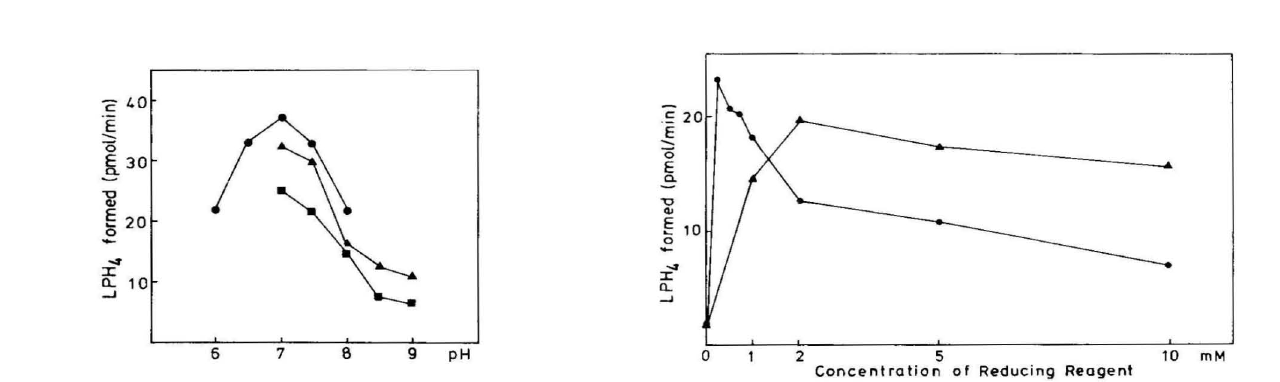
Figure 5. Effect of reducing reagent at various concentra tions on LPH 4 formation. PPH 4 reductase activity was measured in presence of dithioerythritol (- e-e-) or mercaptoethanol (- A - '&'-) at the concentrations shown. LPH 4